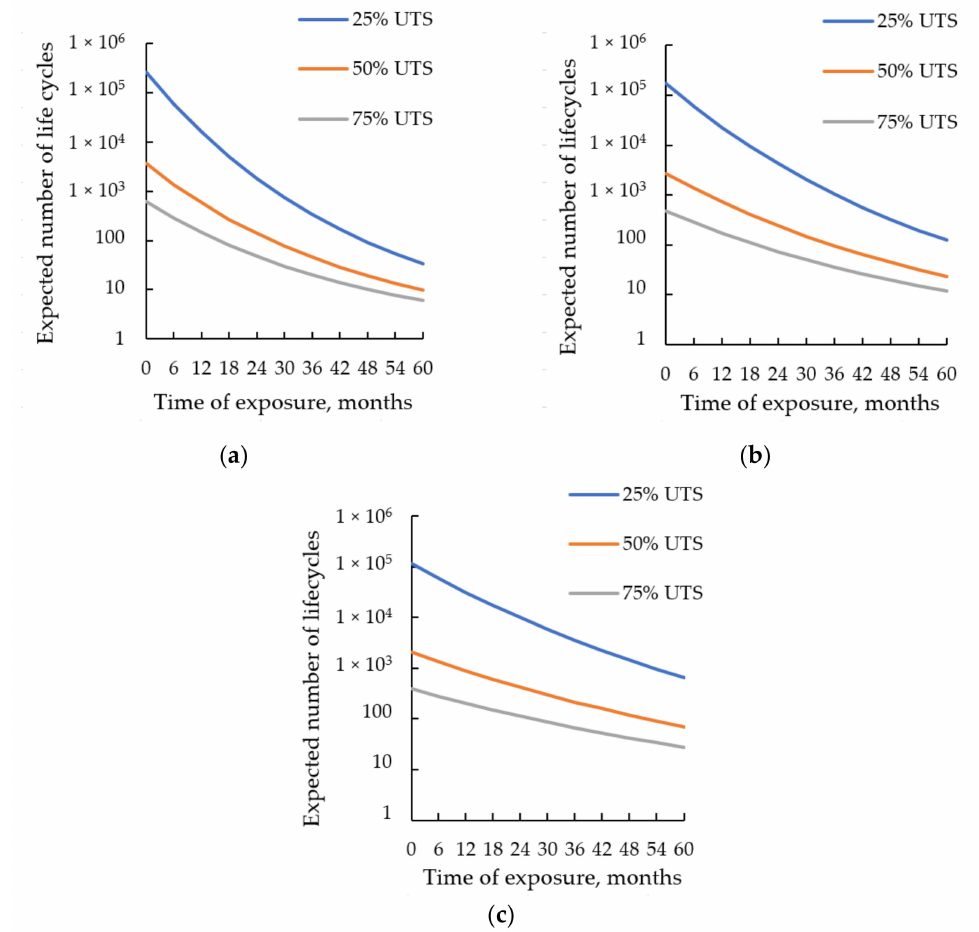
Figure 7. Normalized ( α and β set to a single value) decrease in the expected number of fatigue life cycles, polyester/glass composite: ( a ) UD0 ◦ ; ( b ) (0/90) s; ( c ) (0/45/90) s fiber layout